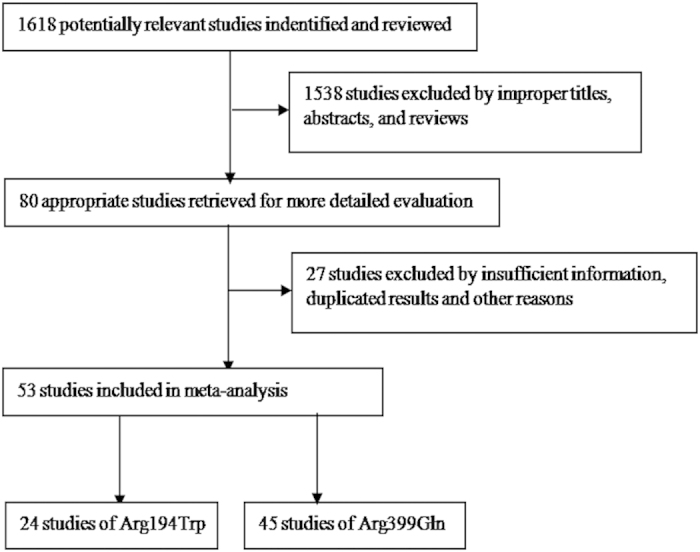
The flow chart of literatures search and selection of included studies.